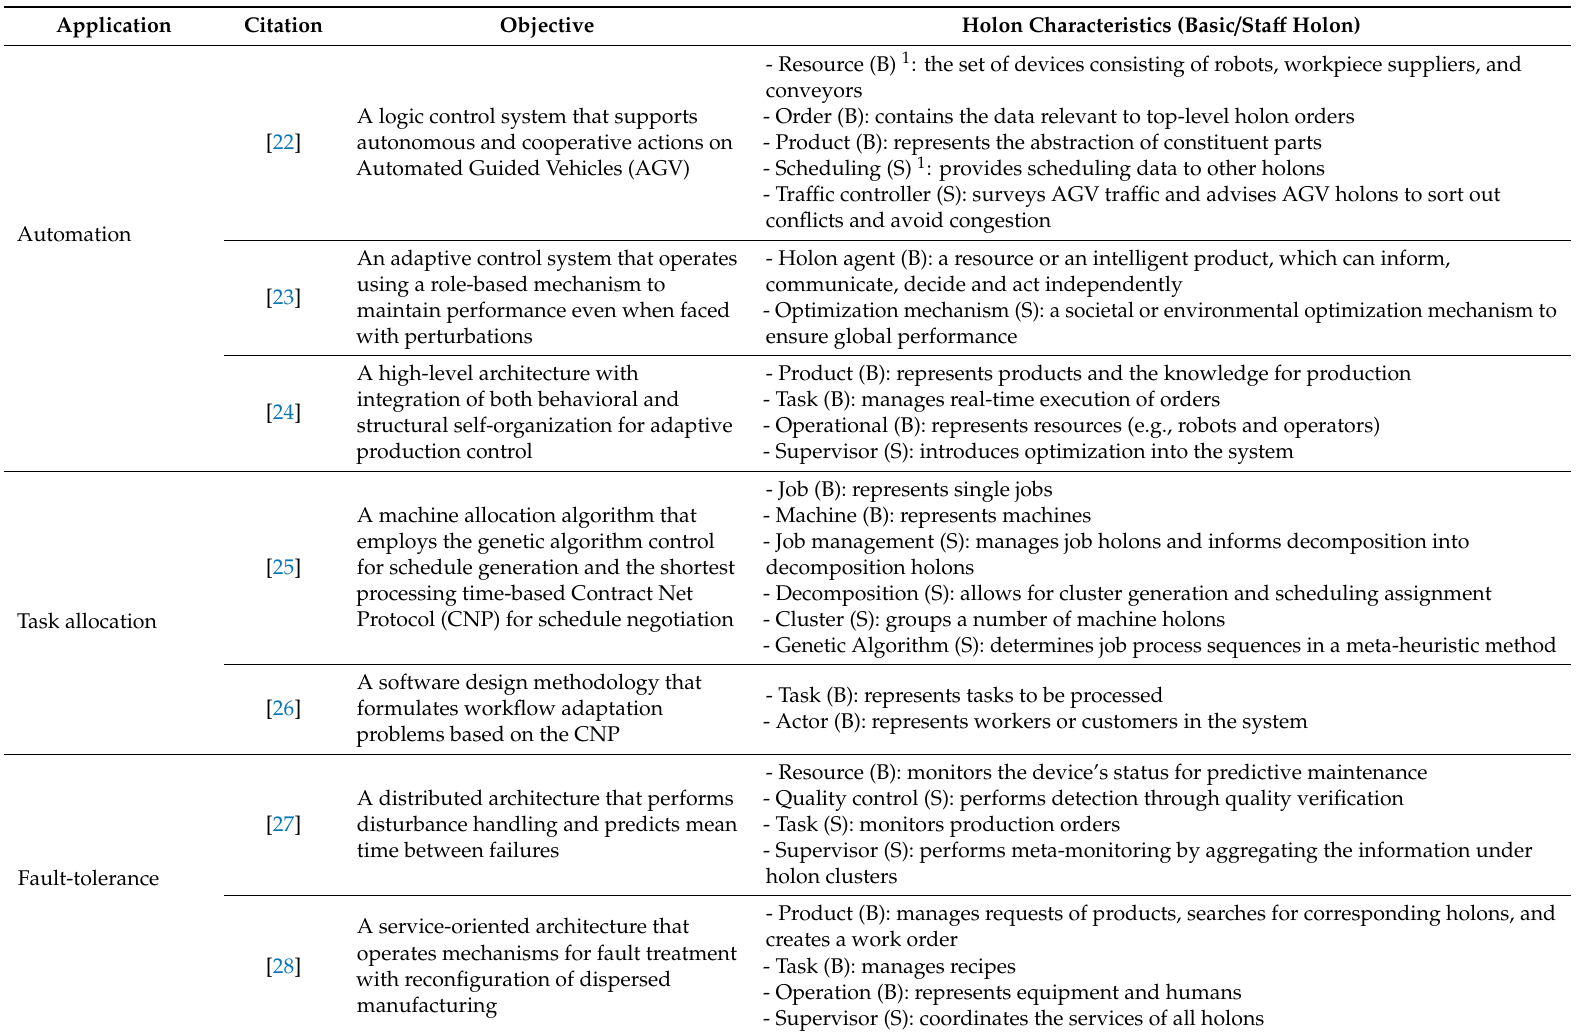
Table 1. A summary of previous literature on Holonic Manufacturing Systems